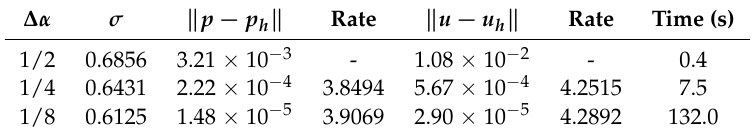
Table 2. The errors and convergence rates in distributed-order with ∆ t 2 ≈ h 2 ≈ ∆ α 4